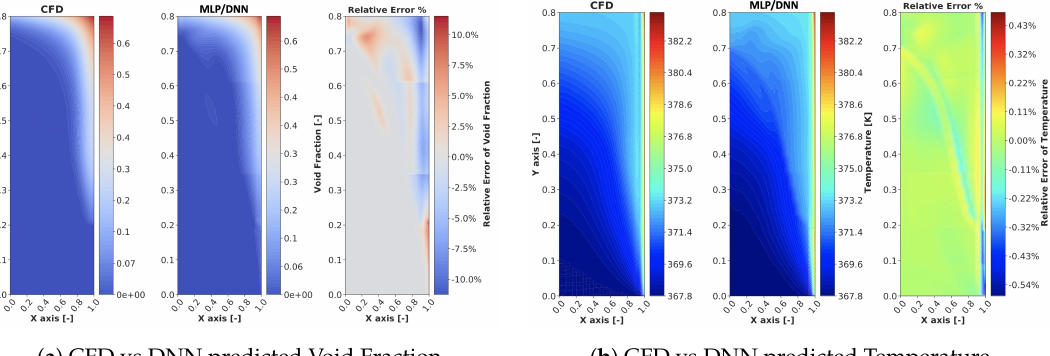
Figure A7. Extrapolation dataset: The CFD, DNN prediction and the relative error for q (cid:48)(cid:48) = 40,000 W/m 2 , u = 0.2 ms − 1 . It can be depicted from Figure A7a that the DNN models fail to accurately predict the void fraction field and have a maximum relative error of 10.5%. However, the DNN model shows an acceptable performance when predicting the temperature field with a maximum relative error of 0.55% as shown in Figure A7b.